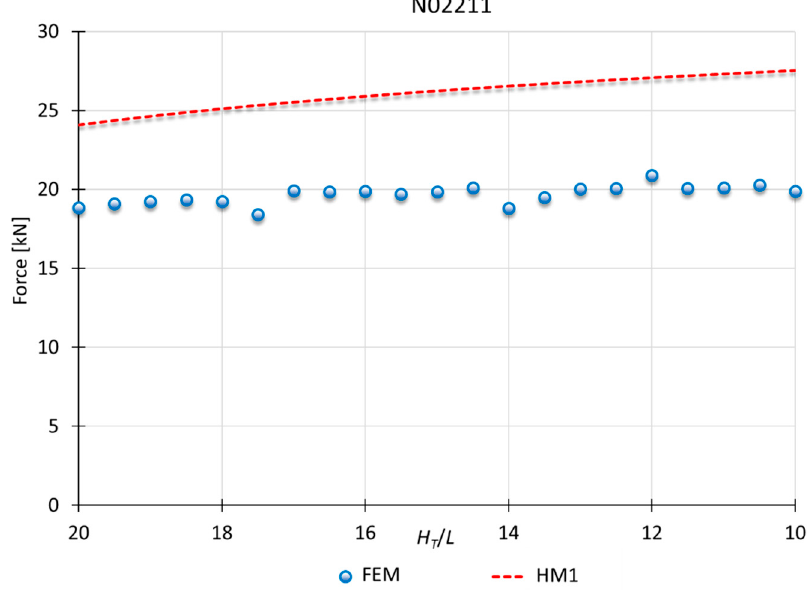
Figure 13. MUBT-FEM comparison for N02211, n = 0.21.